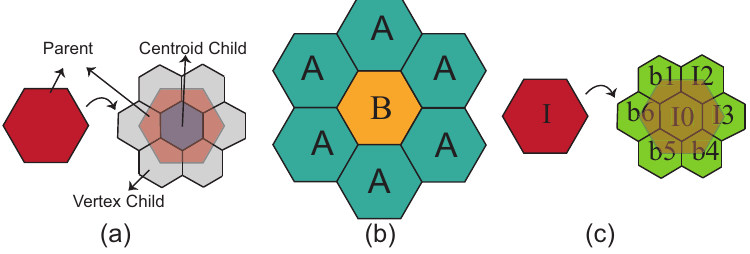
Figure 6. ( a ) A coarse cell (red) is refined to finer cells. Children are categorized as vertex and centroid children. ( b ) Type Bcells are surrounded by type Acells; ( c ) the children of a cell with index Iget indices I0to I6 based on their position relative to their